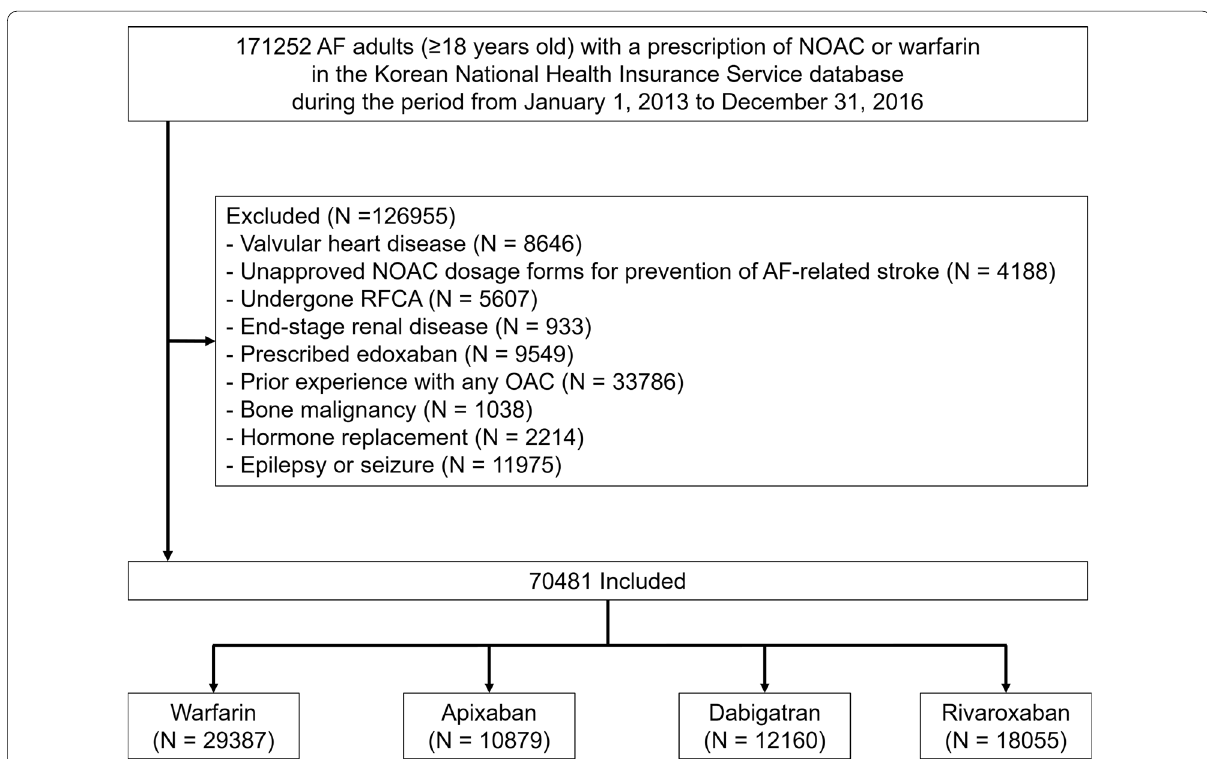
Fig. 1 Flowchart of the enrollment and analysis of the study population. AF atrial fibrillation, NOAC non‑vitamin K antagonist oral anticoagulants, OAC oral anticoagulant; RFCA, radiofrequency catheter